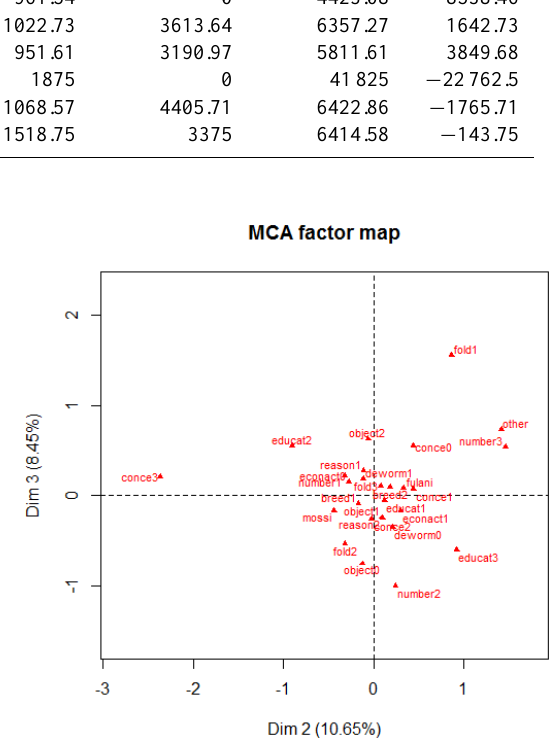
Figure 3. Graphic representation of modalities on axis 2 and 3 (see Table 1 for signification of